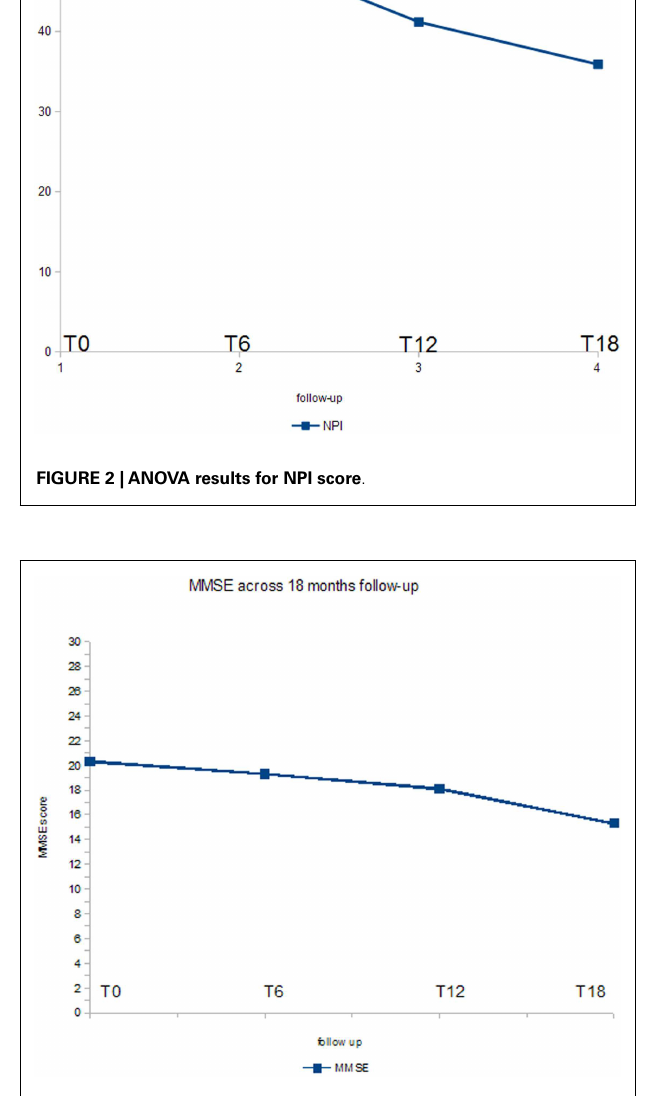
FIGURE 3 |ANOVA results for MMSE score